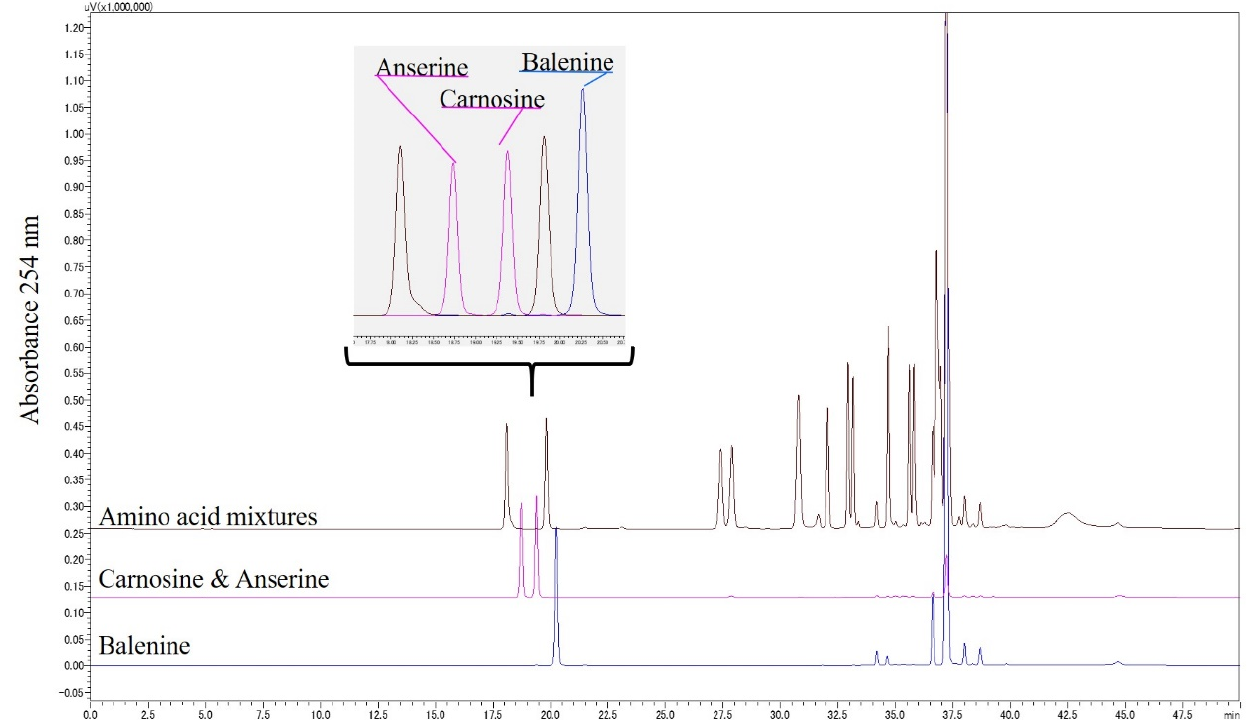
Figure 3. HPLC chromatogram obtained after resolving a PITC-derivatized anserine, carnosine, balenine, and amino acid mixture. The resolution was conducted using a Kinetex EVO C18 column and binary gradient elution with 0.01% trifluoroacetic acid and 60% acetonitrile at a flow rate of 0.5 mL/min.